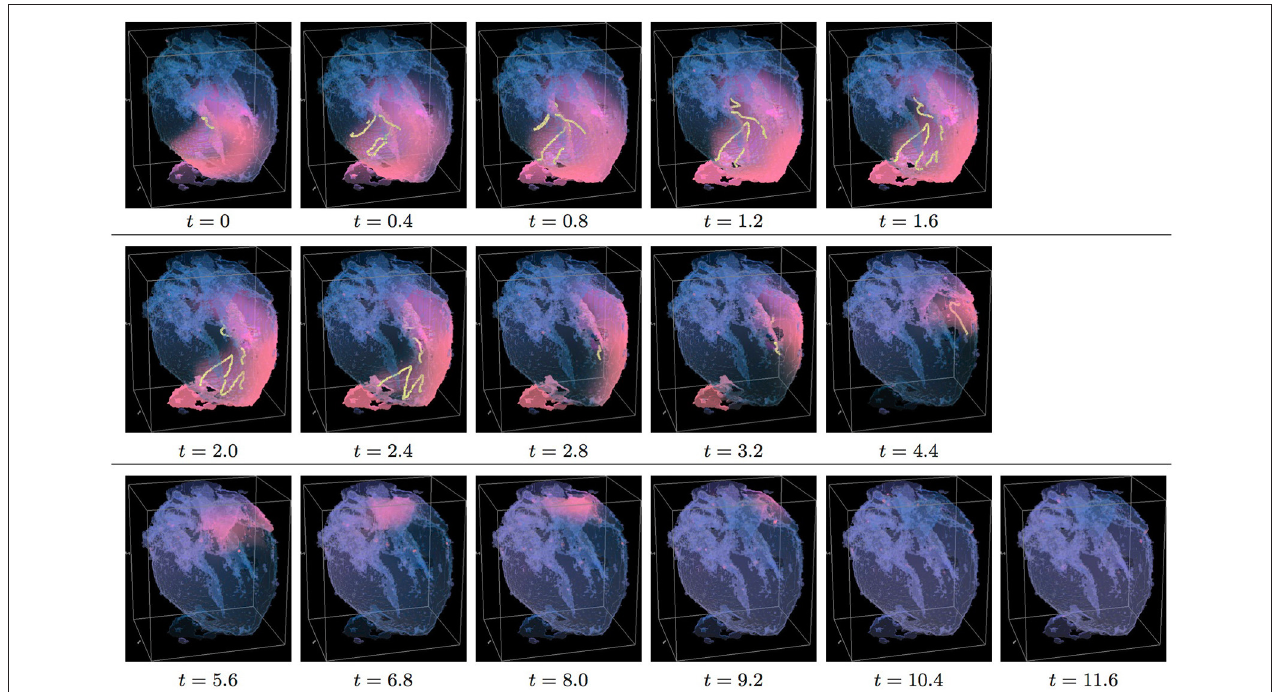
FIGURE 4 | Anisotropic whole heart simulation. The translucent fetal heart is shown in blue, excitation front shown in red (see the color box in Figure 3 ), the yellow lines are the instant organizing filaments of the excitation vortices; time shown under each panel in time units of Equations (1, 2). The anisotropy of the heart causes the fast transient distortion of the organizing filament of the initial excitation vortex and drift toward the inexcitable boundary of the heart, ultimately resulting in the very fast self termination of the excitation vortex (See Supplementary Video 4